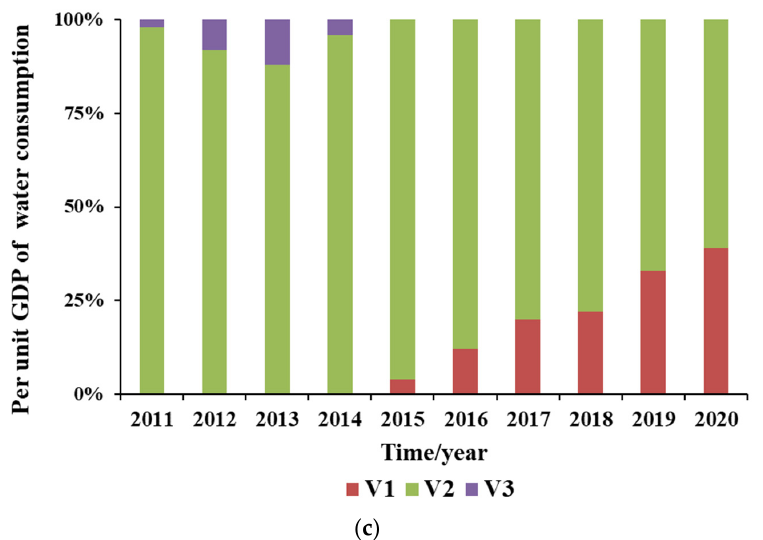
Figure 2. Evaluation membership degree of indicator. ( a ) Total groundwater resource; ( b ) degree of groundwater development and utilization; ( c ) per unit GDP of water consumption.